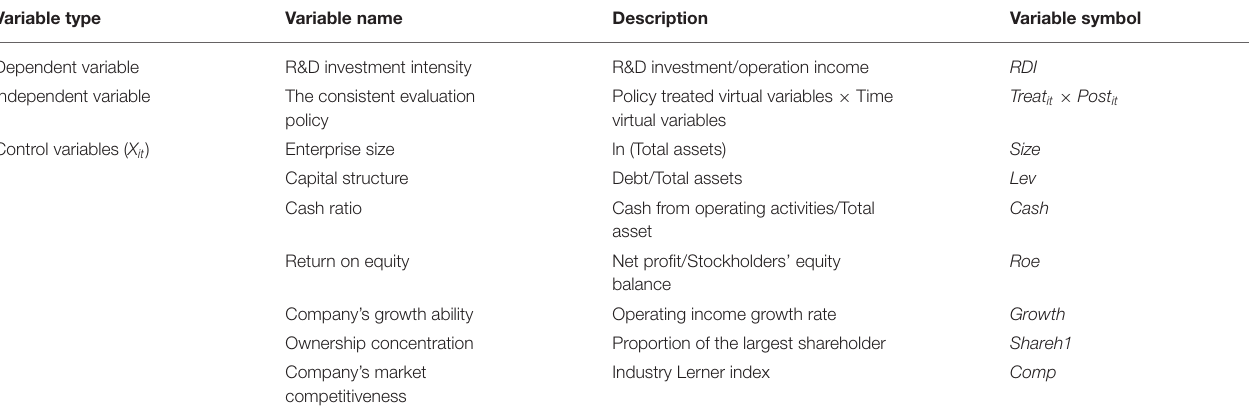
TABLE 1 | Research